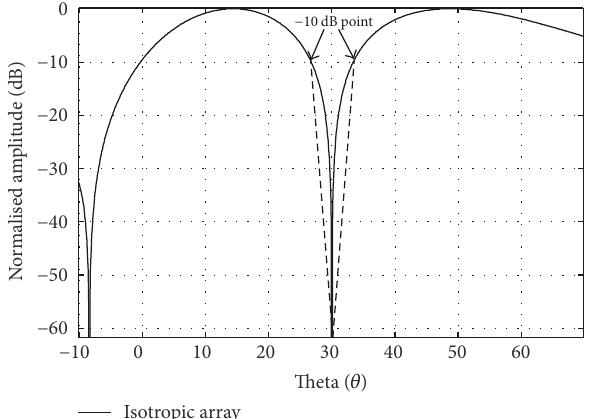
Figure 3: Presentation of slope lines defined to calculate the difference pattern slope.